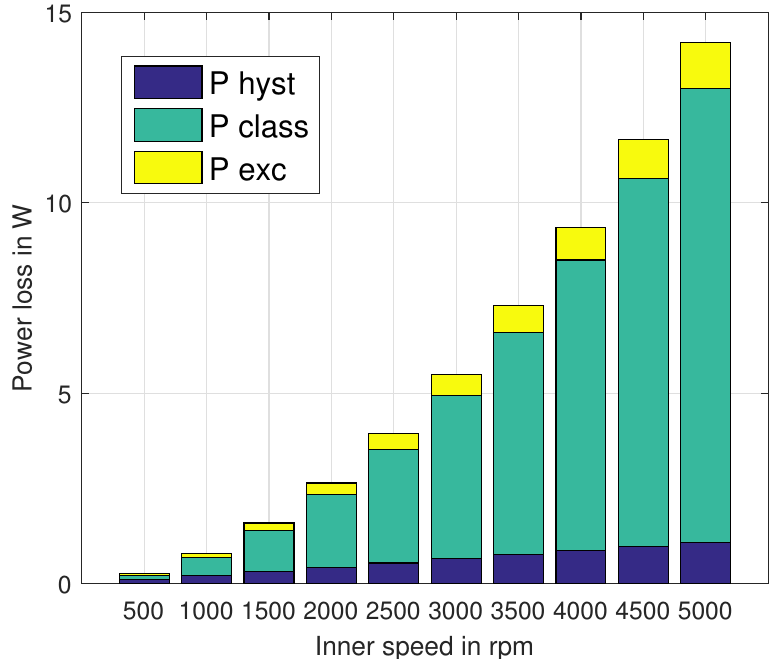
Figure 14. Iron poles loss components. The losses are computed varying the rotors speed at the maximum torque